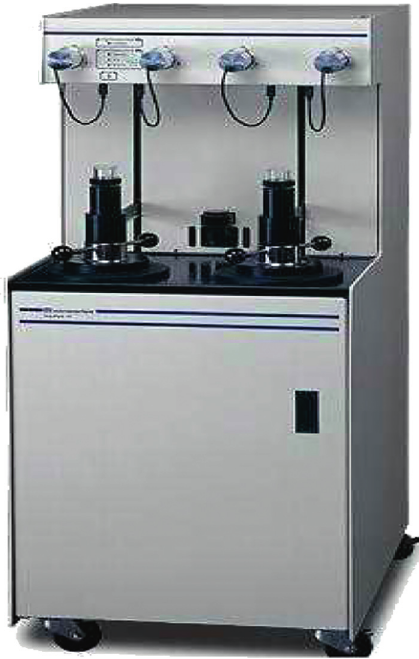
Figure 4: AutoPore IV 9500 mercury